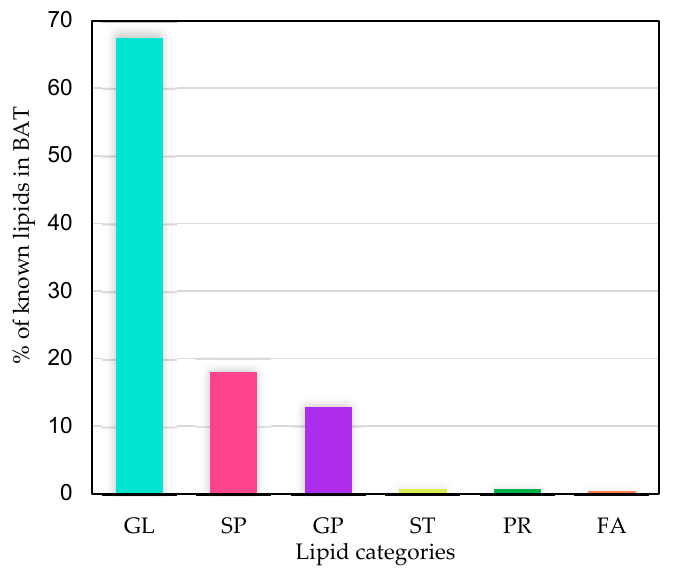
Figure 2. Percentages of the different categories of found known lipids in all lamb brown adipose tissue (BAT) samples. GL, glycerolipids; SP, sphingolipids; GP, glycerophospholipids; ST, sterol lipids; PR, prenol lipids; FA, fatty acyls.